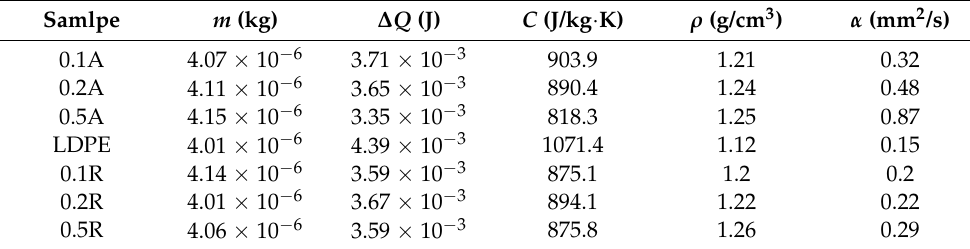
Table 1. Experiment data of